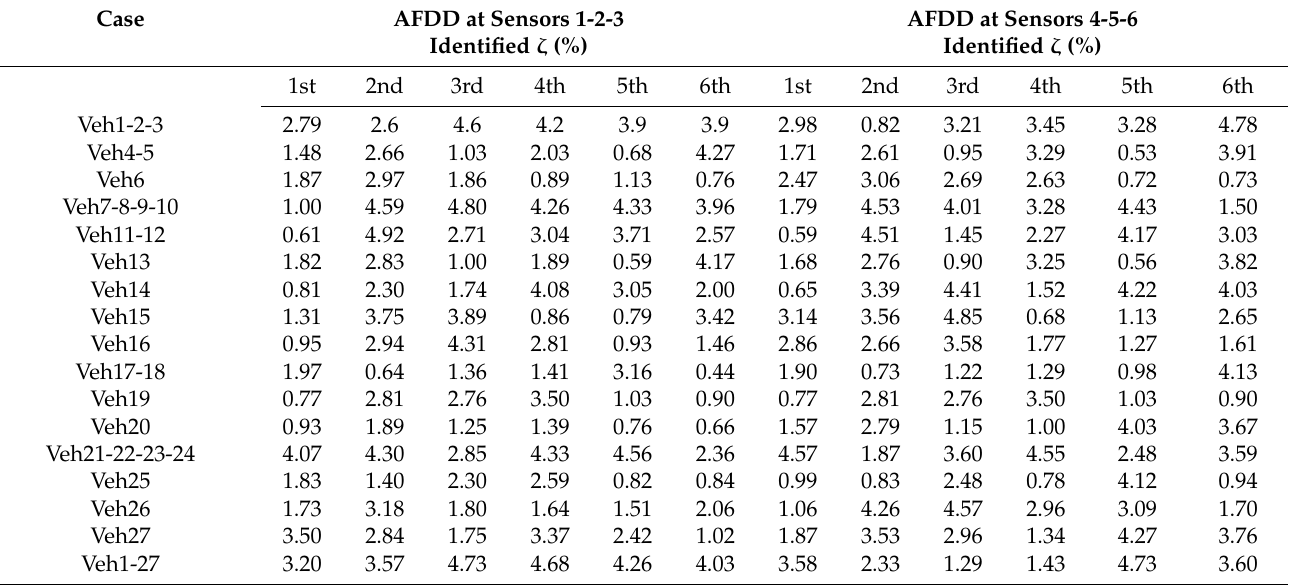
Table 12. Identified damping ratios with FDD method in the vertical direction (Z